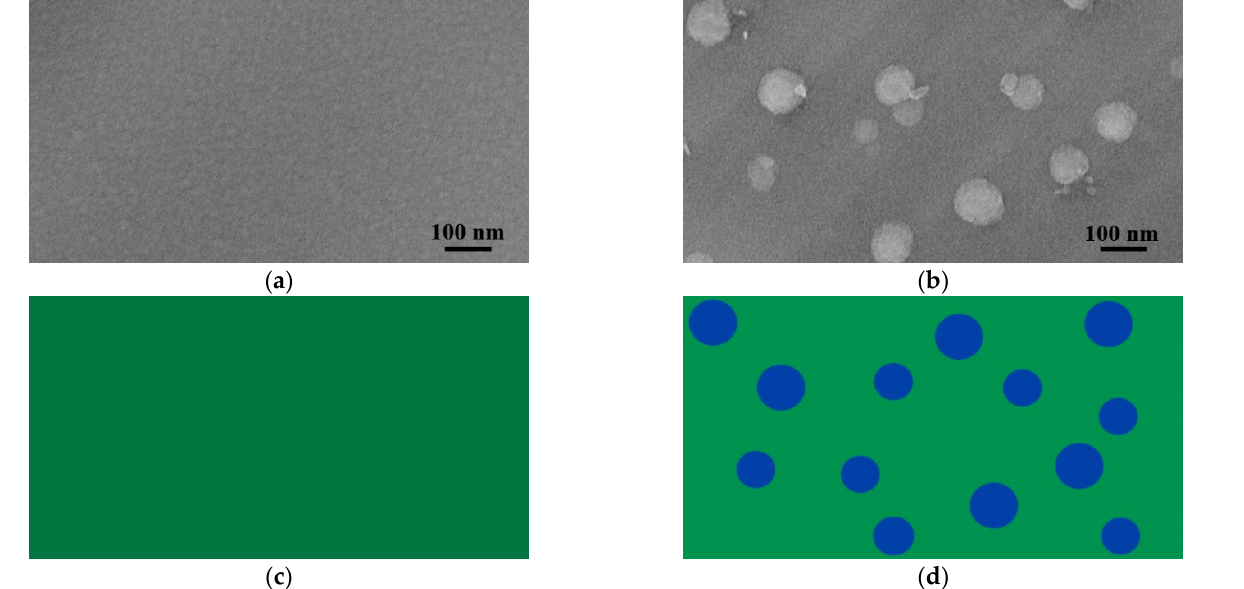
Figure 4. Hydrogen formation in RF-sputtered a-SiNx:H thin films. SEM image of a layer surface ( a ) before annealing and ( b ) after annealing at 65 °C. Schematic representation of the layer surface ( c ) before annealing and ( d ) after annealing.